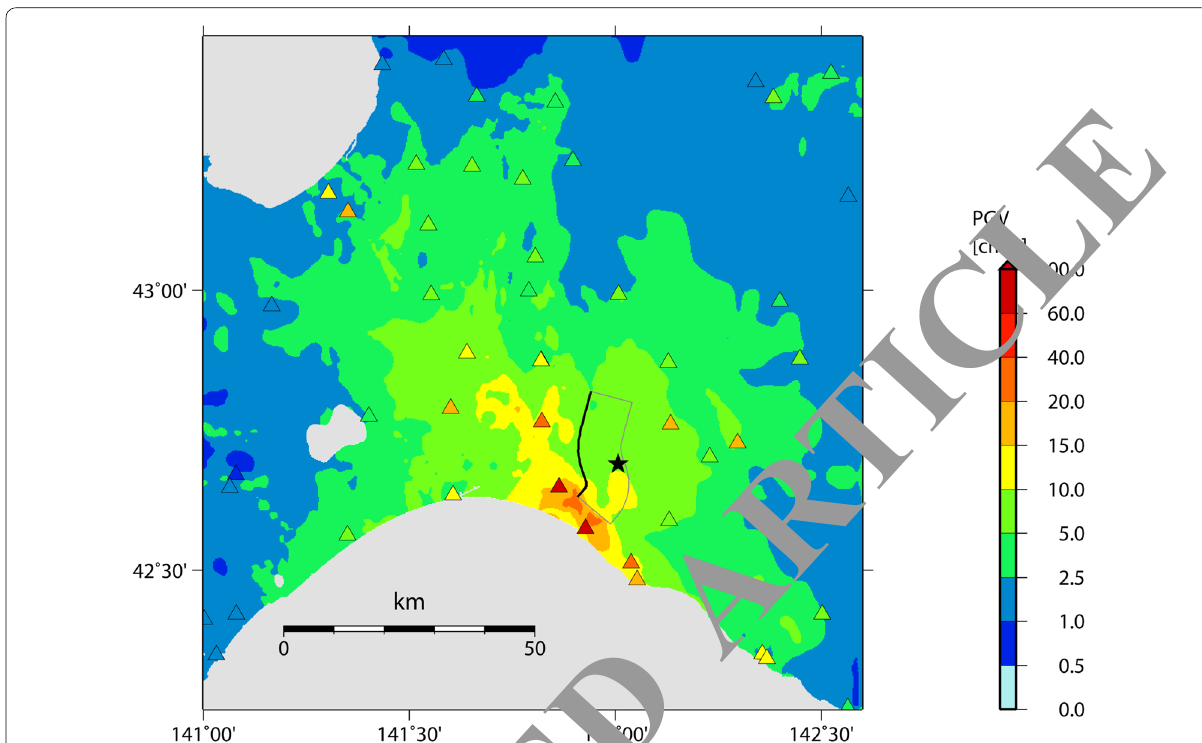
Fig. 5 Simulated PGV distribution. The PGV is the maximum absolute amplitude of the vector sum of the three-component velocity waveform low-pass filtered at 0.5 Hz. The triangles denote the observed PGV at K-NET and KiK-net stations for